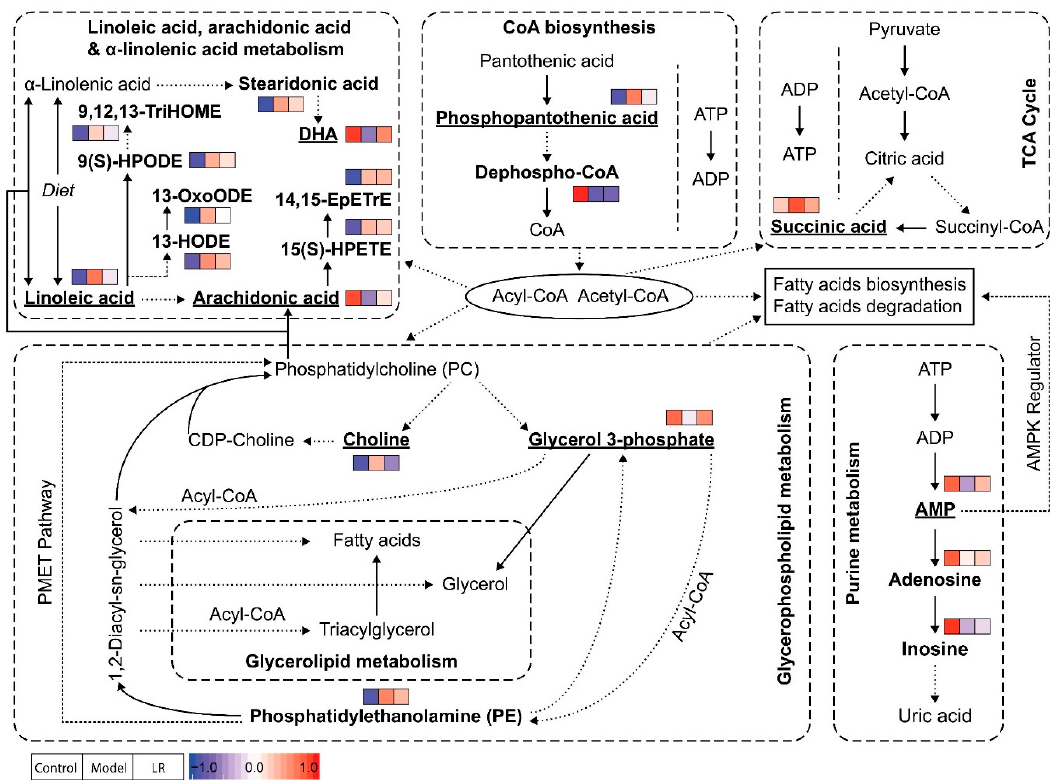
Figure 5. Possible pathways related to the affected metabolites in the liver of mice from the groups of control, model, and LR. The metabolites identified in this study were highlighted in bold, and the eight key metabolites were underlined. Relative levels of identified metabolites were normalized and presented in color (blue—the lowest level; red—the highest level) following the order of control group, model group, and LR group.